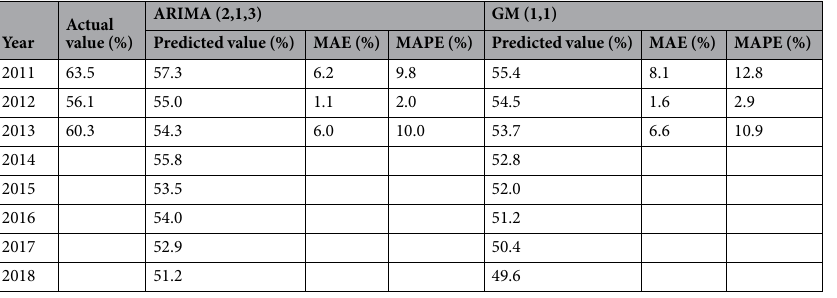
Table 3. Prediction results of two